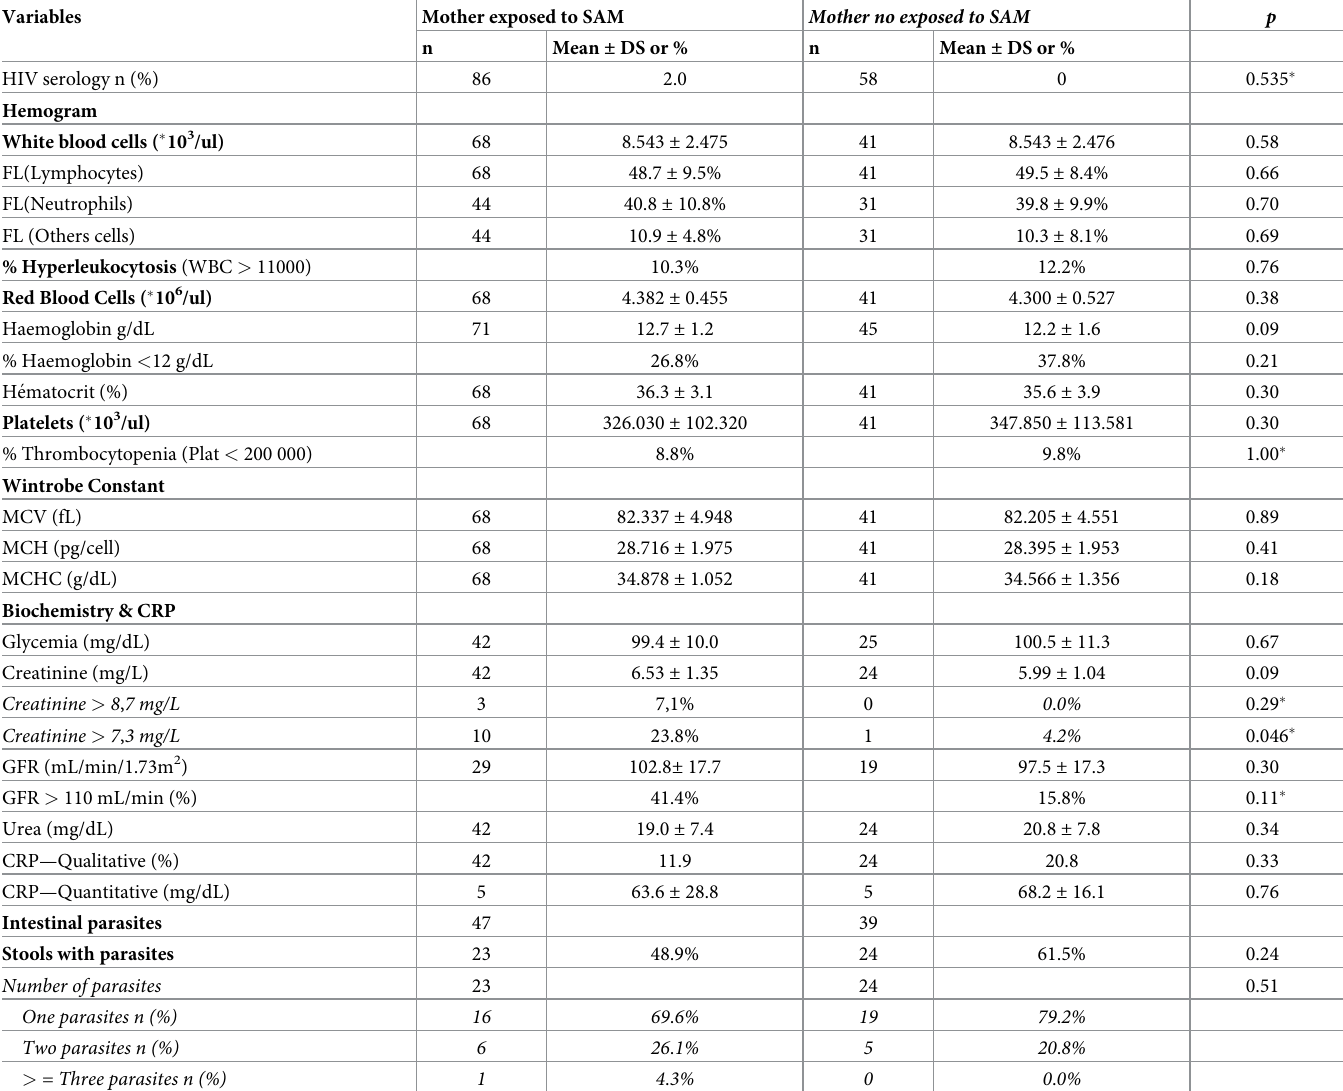
Table 3. Biological indicators, figurative elements of the blood, direct stool